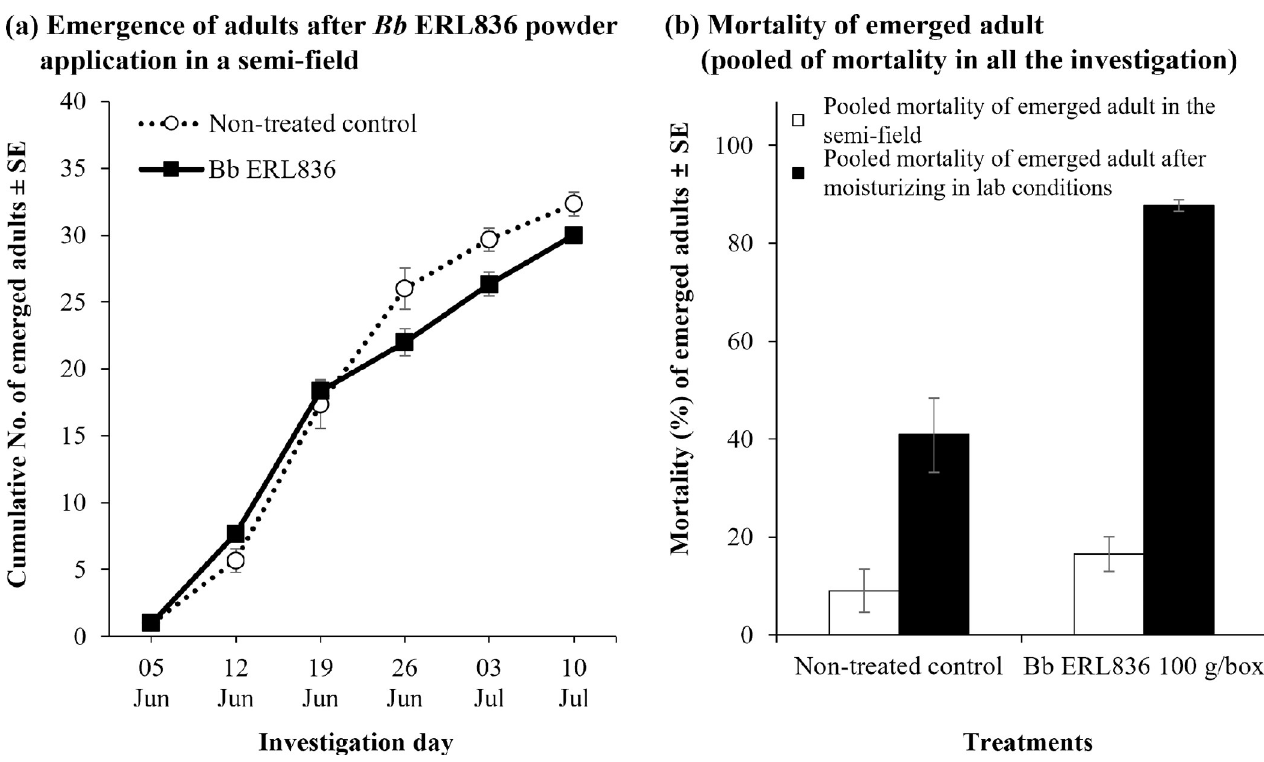
Fig 5. Control efficacy of B . bassiana ERL836 against M . alternatus by fungal powder formulation pre–treatment of pine logs artificially infested with larvae in semi–field conditions. The surfaces of pine logs artificially infested with M . alternatus larvae were powdered with B . bassiana ERL836 fungal powder formulation, and then the logs were piled and sealed with a film. At weekly intervals, the number of emerged and dead M . alternatus adults was counted. The error bars represent the standard error of the mean of the number of emerged adults (a). In the semi–field, mortality of adults at each investigation time was pooled, and additionally to see the possibility of infection in the alive adults, alive adults were moved to a lab and kept in moisturized Petri–dishes for 14 days and mortality was checked and pooled. The error bars represent the standard error of the mean mortality rate (b).